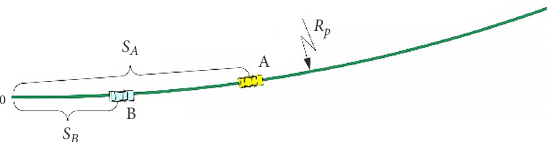
Figure 7. Example of synchronization operation in a lane (source: created by the authors)